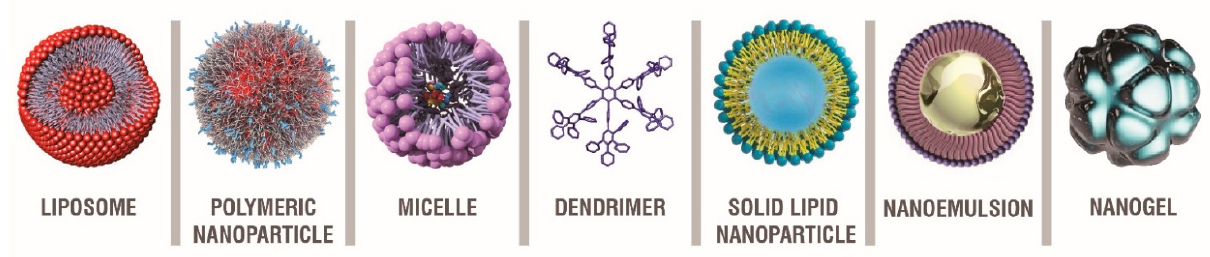
Figure 7. Main nanosystems exploited to delivery drugs to BBB in the treatment of neurodegenerative diseases.